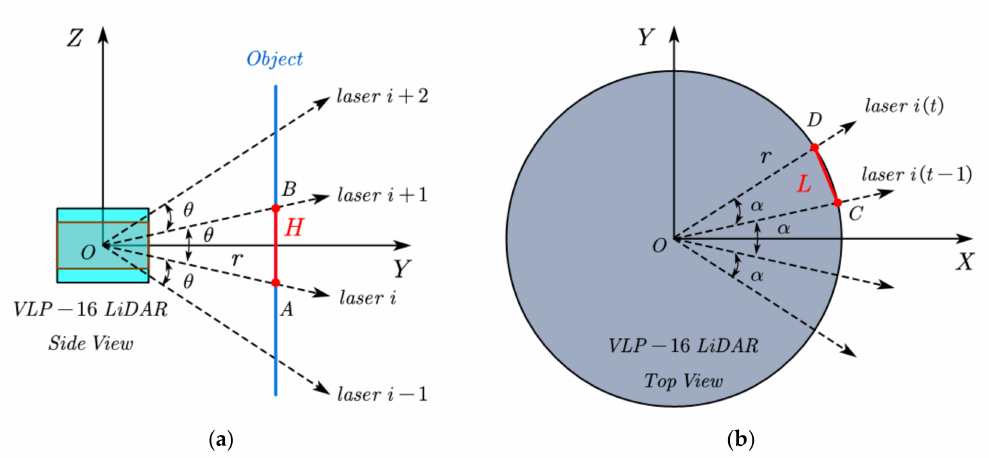
Figure 6. The schematic diagram for calculating the distance between two adjacent points of LiDAR. ( a ) The distance in vertical direction; ( b ) The distance in horizontal